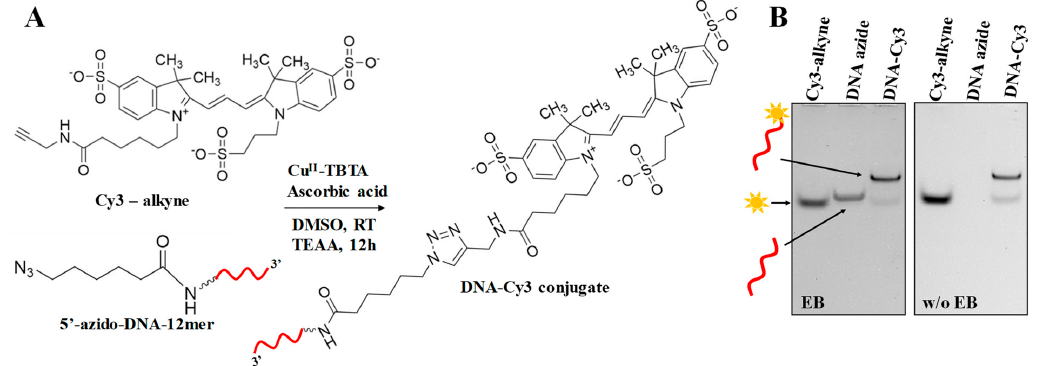
Figure 2. Coupling of 5 ′ -azido-DNA (ODN-azide) with Cy3-alkyne by “click” chemistry and prod- uct formation investigation. ( A ) Generalized reaction diagram interaction between Cy3-alkyne and 5 ′ -azido-DNA in 2:1 ratio in the presence of Cu(I) catalyst. ( B ) Denaturing 32% PAGE demonstrating band shifts between reactants (Cy3 and DNA azide) and product (DNA-Cy3).